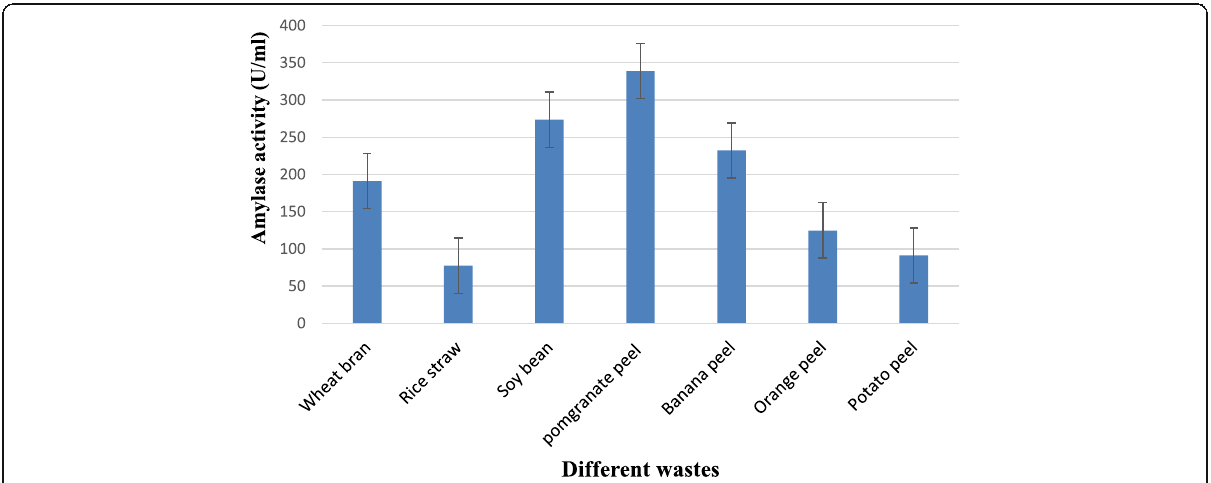
Fig. 2 Effect of different wastes on α -amylase production by Aspergillus terrus